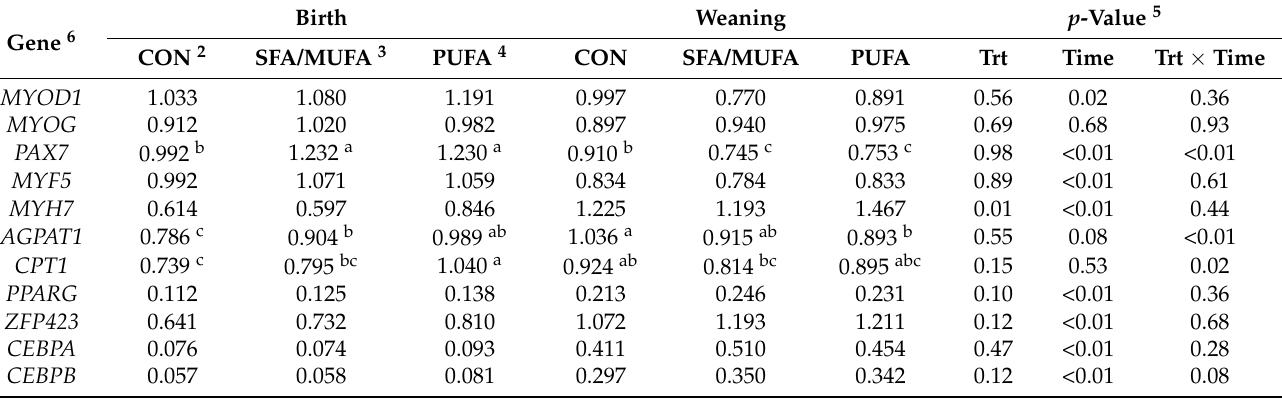
Table 11. Relative mRNA expression of genes regulating myogenesis and adipogenesis in the longissimus muscle of the steers (4 steers per group) born from dams supplemented for the last 82 ± 5 d of gestation with soybean hulls mixed with either whole-shelled corn (CON), Ca salts of saturated/monounsaturated fatty acids (SFA/MUFA), or Ca salts of polyunsaturated fatty acids (PUFA) 1